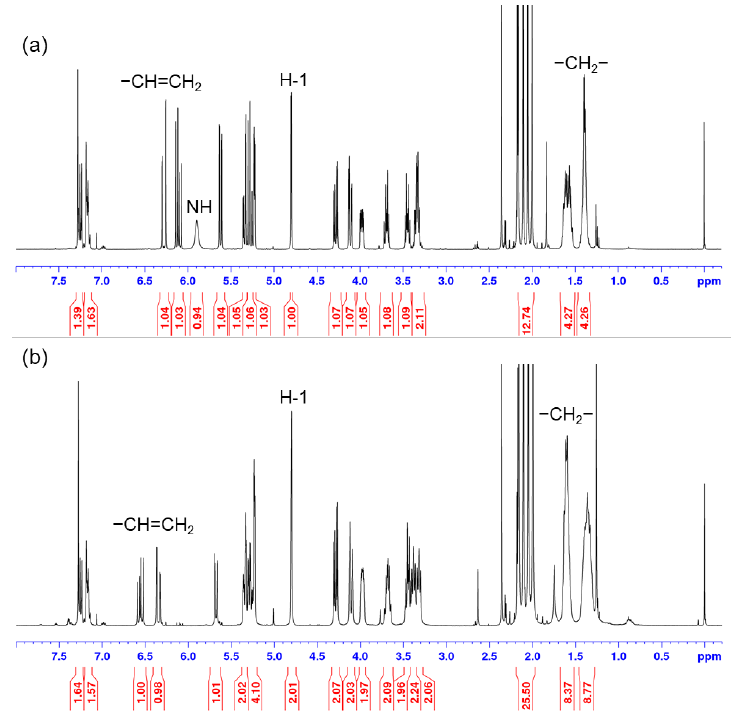
Figure 1. 1 H NMR spectra of ( a ) N -hexyl α - D -acetylmannosyl acrylamide ( 2 ) and ( b ) N , N -bis(hexyl α - D -acetylmannosyl) acrylamide ( 3